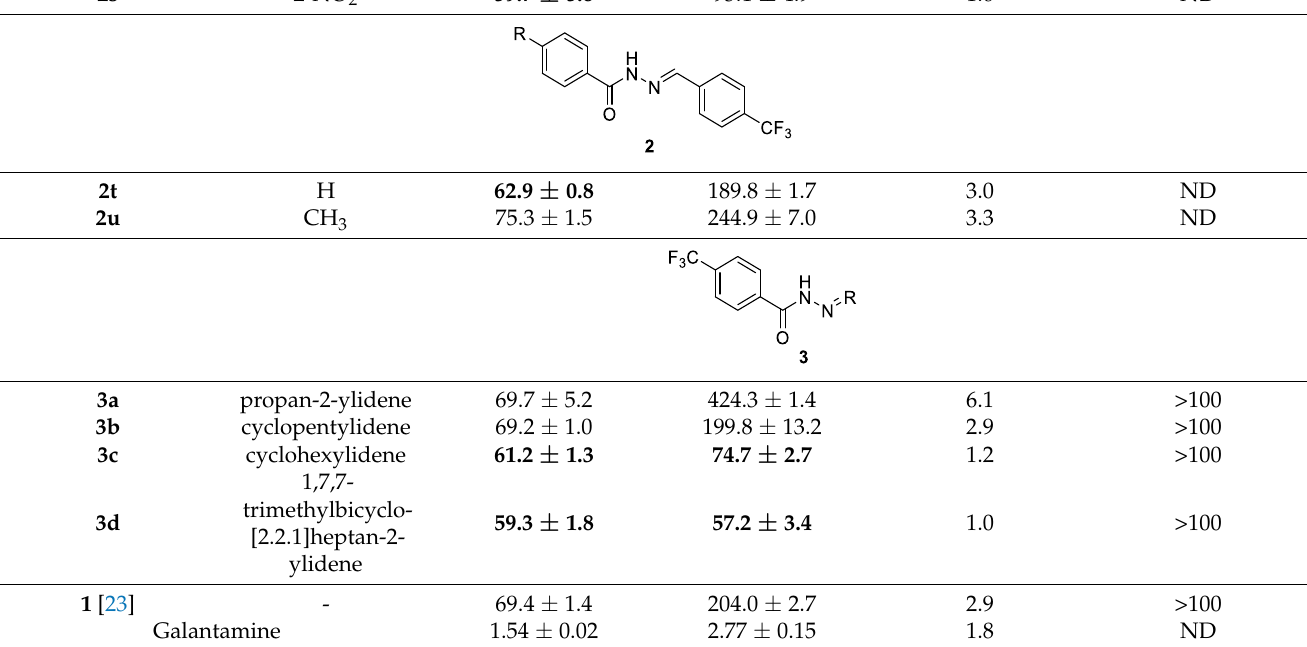
Table 1. Inhibition of AChE and BuChE, selectivity and toxicity data of 1 – 3